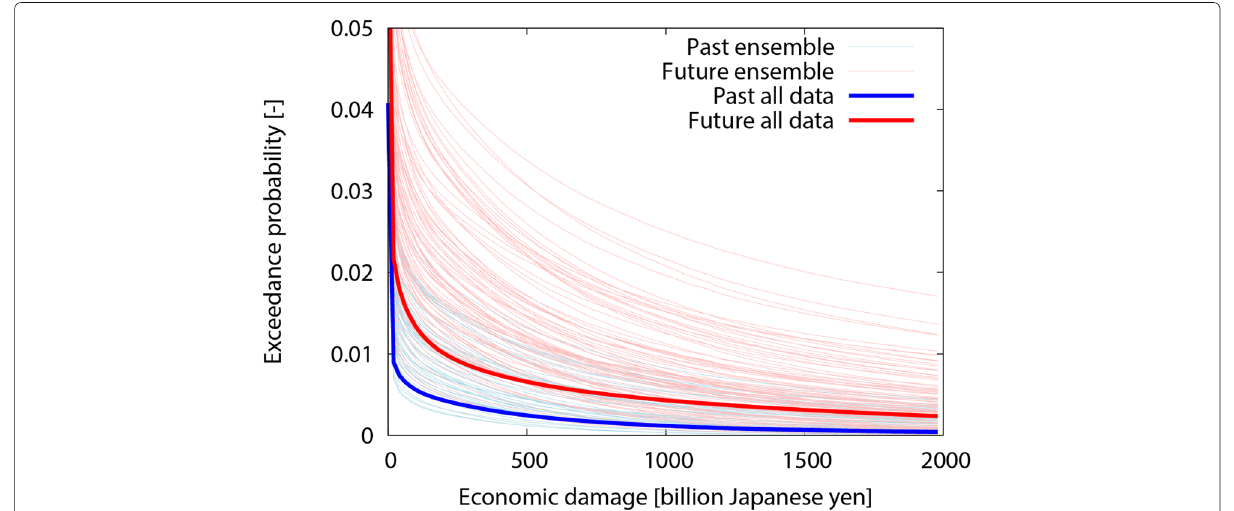
Fig. 9 Exceedance probability of economic damage to Yodo river flooding by d4PDF-R (past: blue, future: red), after Tanaka et al. (2018)